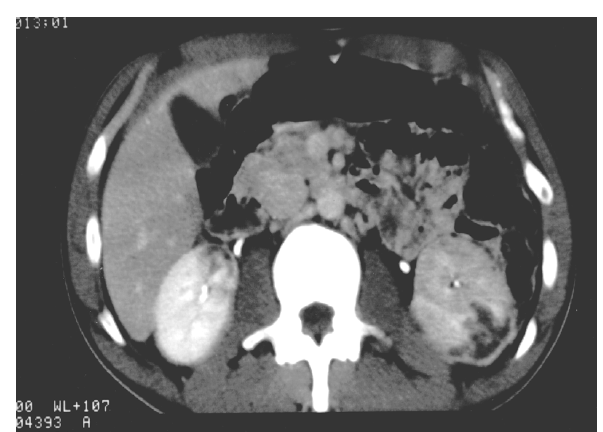
Figure 1 – Abdominal computerized tomography with venous contrast revealing diffuse filling defects in left kidney and areas of focal ischemia in right kidney.